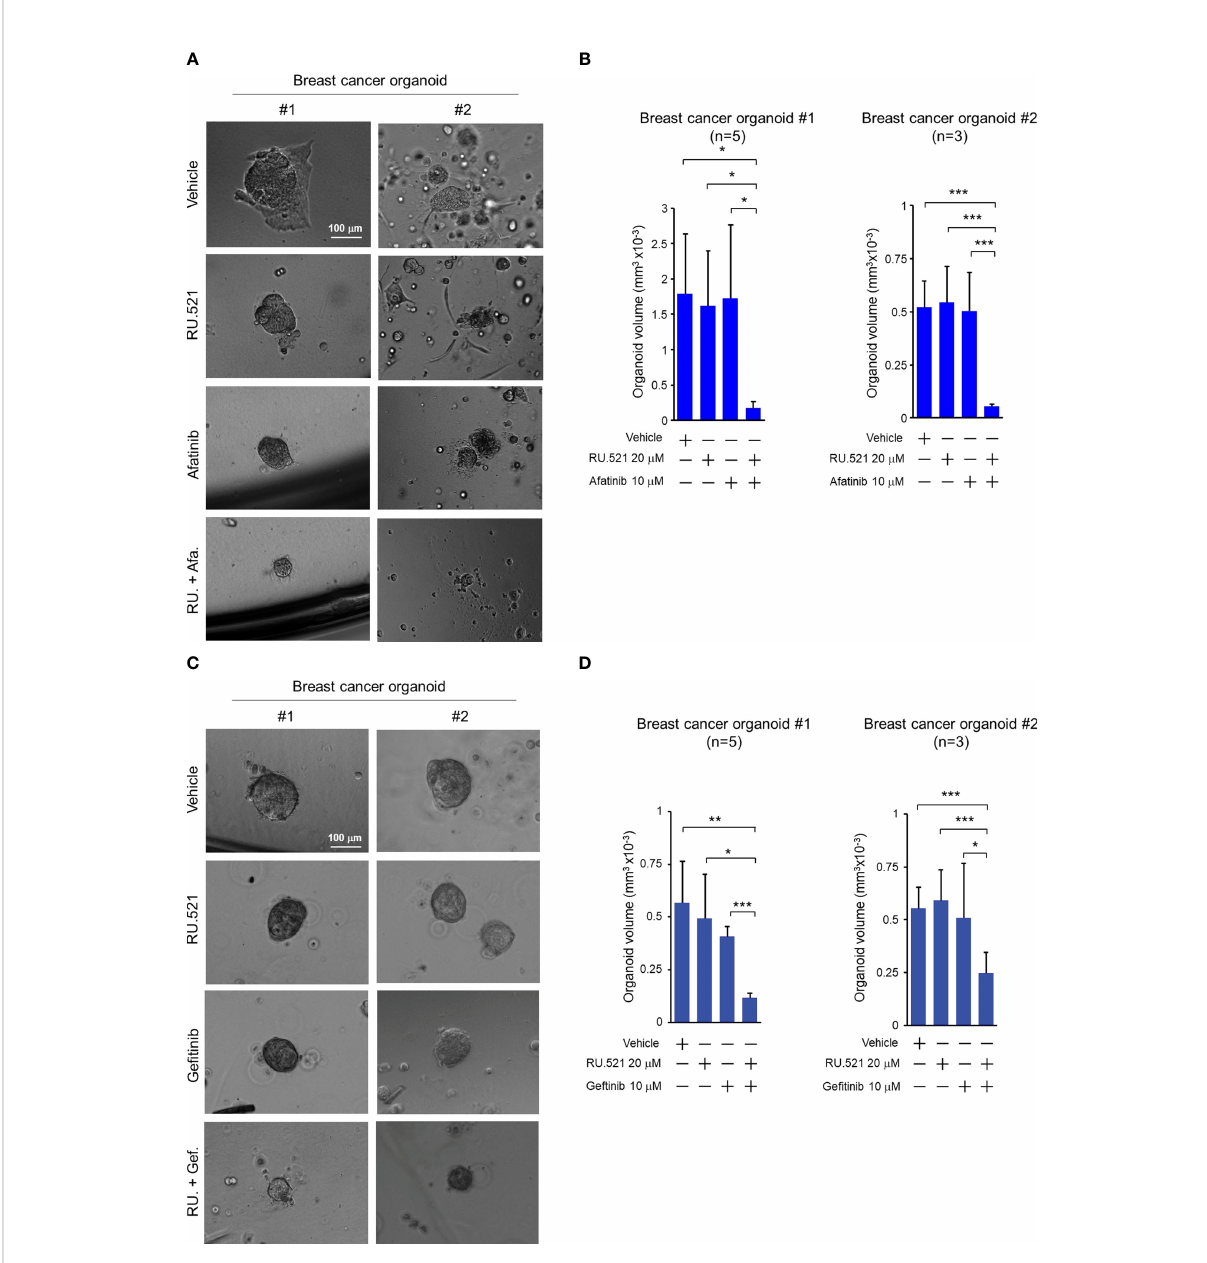
FIGURE 7 Combined treatment by RU.521 and EGFR inhibitors suppressed the growth of tumor organoids derived from breast cancer patients. Tumor organoids derived from breast cancer patients (#1 and #2) were cultured and treated with RU.521 alone (20 m M), EGFR inhibitors (afatinib (A) or ge fi tinib (C)) alone (10 m M), or co-treated with RU.521 plus an EGFR inhibitors (afatinib (A) or ge fi tinib (C)) in serum-replete media for 72 hr. (A, C) Representative images of organoids captured by an inverted microscope at 100x magni fi cation are shown. Bar, 100 m m. (B, D) the volumes of the derived organoids (n=5 of #1, n=3 of #2 for each treatment) after the indicated treatments were estimated by the sphere volume formula (V=4/3 p r3). The data of three independent experiments were shown as means ± SD, and statistical signi fi cance was plotted by Student ’ s t-test. *, p < 0.05; **, p < 0.01; ***, p <